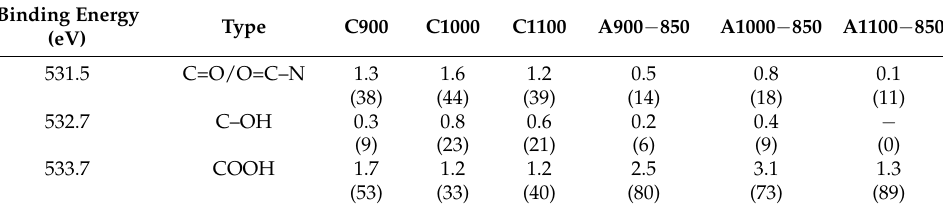
Figure 5. X-ray photoelectron spectroscopy (XPS) O 1 s spectra: ( a ) C900; ( b ) C1000; ( c ) C1100; ( d ) A900 − 850; ( e ) A1000 − 850; and ( f ) A1100–850. The values are given in an atomic ratio (%) of total intensity.